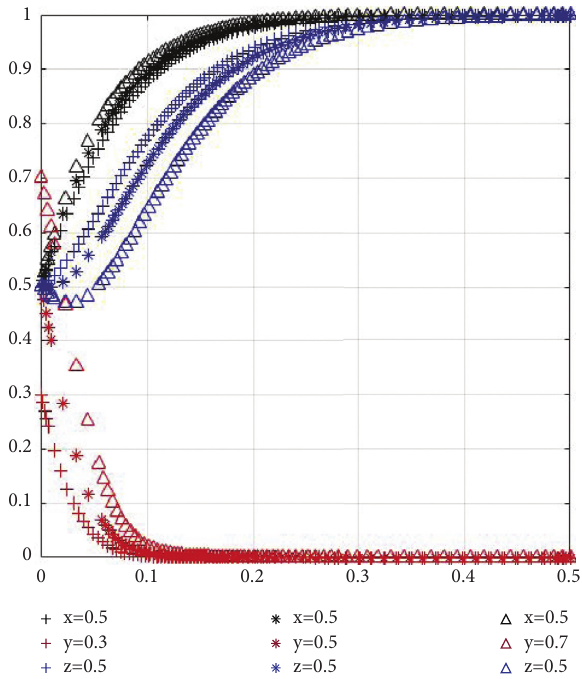
Figure 4: The evolution result of the change of public participation willingness z ( z � 0.3 ⟶ z � 0.5 ⟶ z �